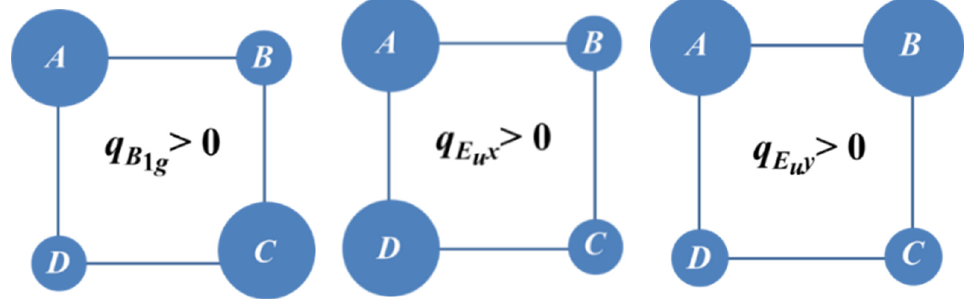
Figure 3. Pictorial representation of the coordinates of symmetry adapted PKS vibrations of the square-planar unit. The balls mimic expanded (large) and compressed (small) redox sites.